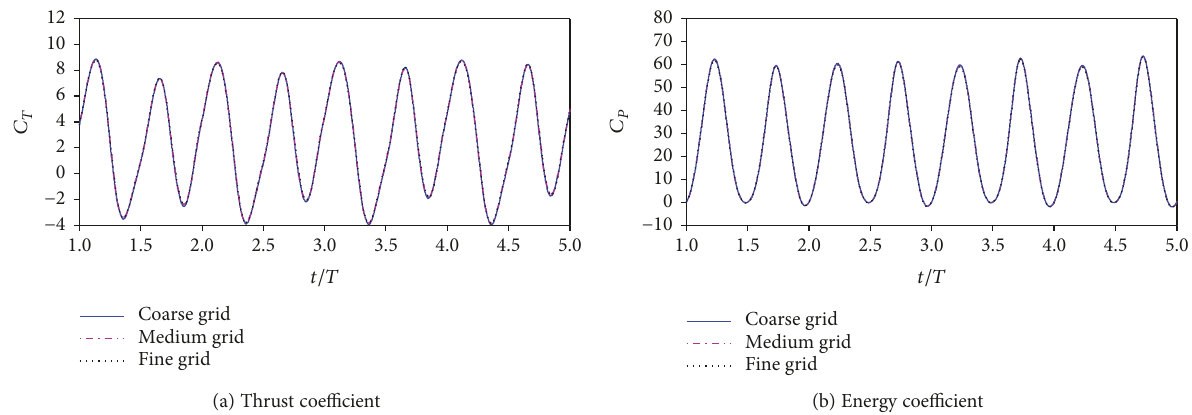
Figure 3: The time variation of thrust and energy coe ffi cient with three di ff erent grid systems.